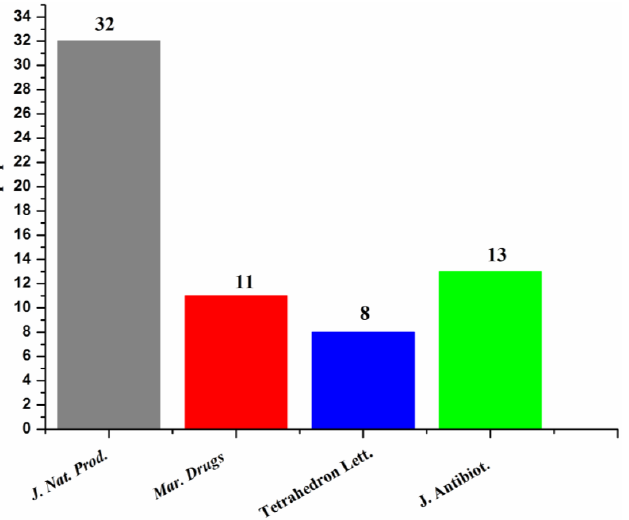
Figure 7. Journals that reported new halogenated compounds and numbers of papers published (1994–2019).